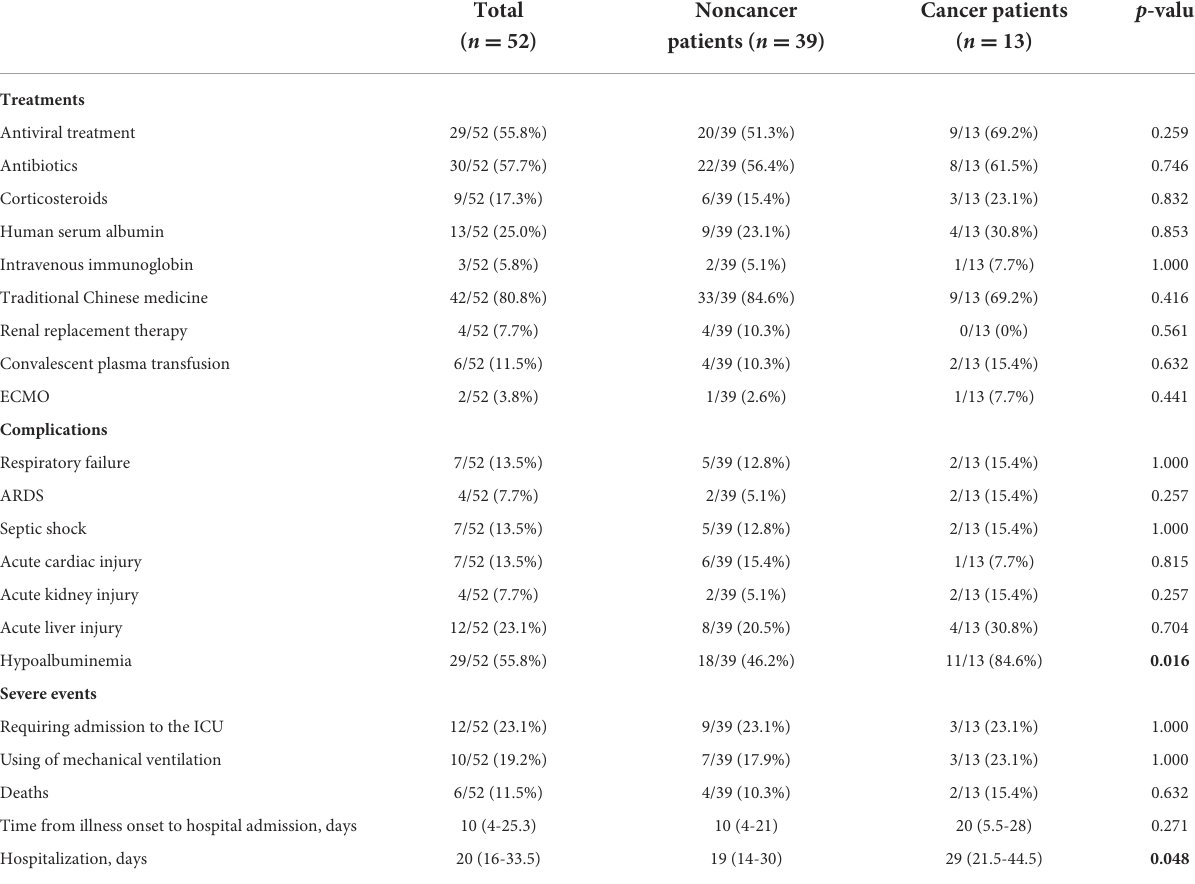
TABLE 4 Treatments, complications and outcomes of COVID-19 patients with and without cancer on